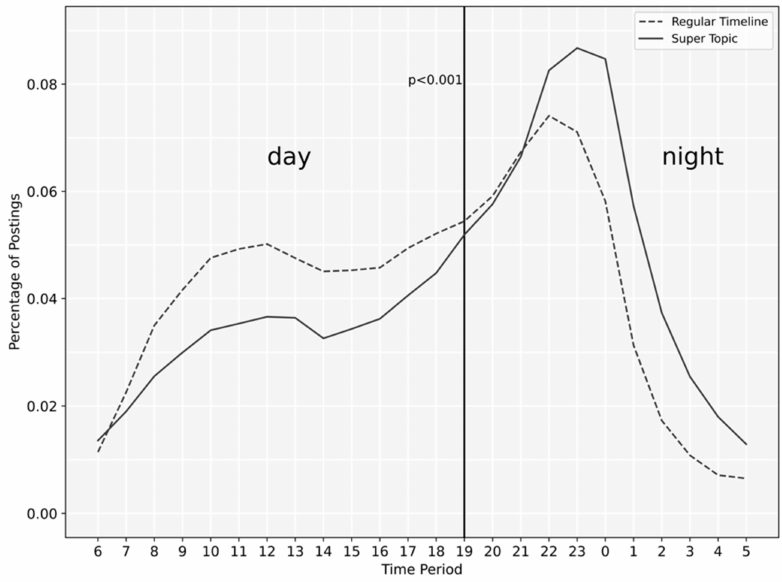
Figure 5. Diurnal activity patterns of users in Depression Super Topic and regular